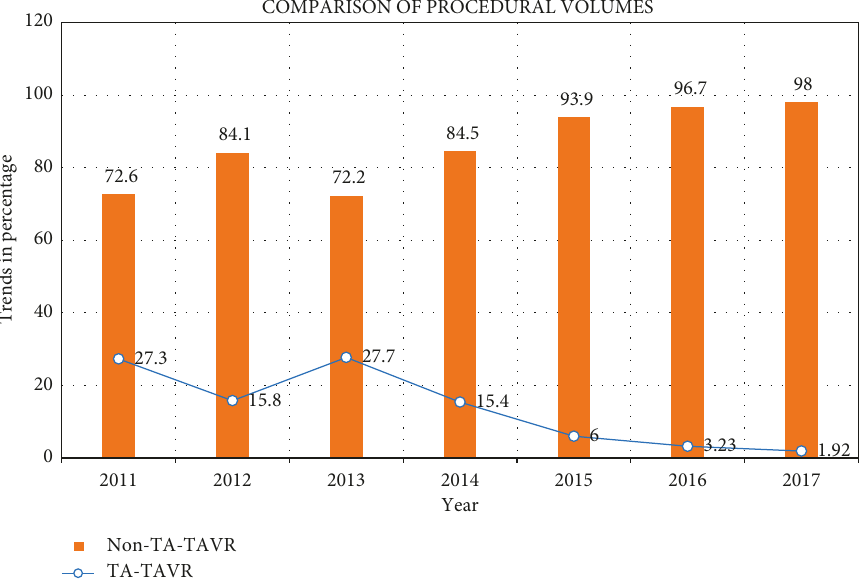
Figure 1: Comparison of procedural volumes from 2011–2017.